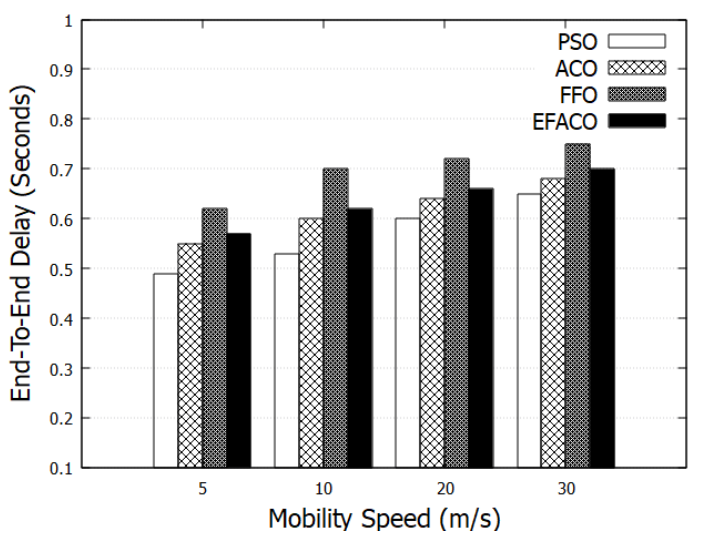
Figure 9. Comparison between proposed PSO, ACO, FFO, EFACO for End-to-End Delay with mobility speed.